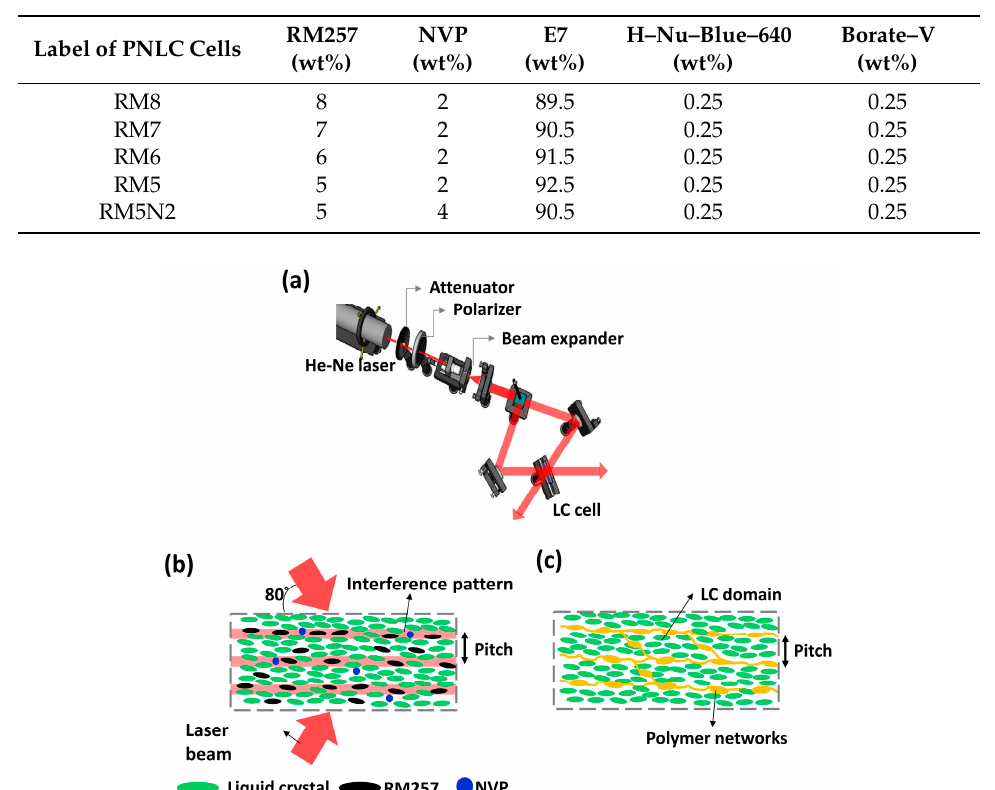
Table 1. Ingredient percentages of the LC mixture filled in experimental PNLC cells for processing holographic exposure.